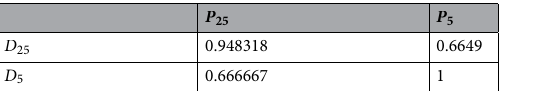
Table 1. NMI between a set of detected communities and that of planted communities for the block-of- blocks-of-blocks. In the most left column, D 25 and D 5 symbolize sets of 25 and 5 communities detected from the network for α = 0.028712 and 0.176854 (indicated by the vertical dotted lines with numerals ‘25’ and ‘5’ in Fig. 6c), respectively. In the top row, P 25 and P 5 symbilize sets of 25 and 5 communities constituting the first and second layers of the planted hierarchy,